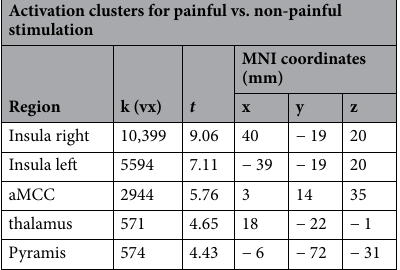
Table 1. Significant brain activation clusters for contrast painful vs. non-painful stimulation with cluster size (k), t-value and MNI